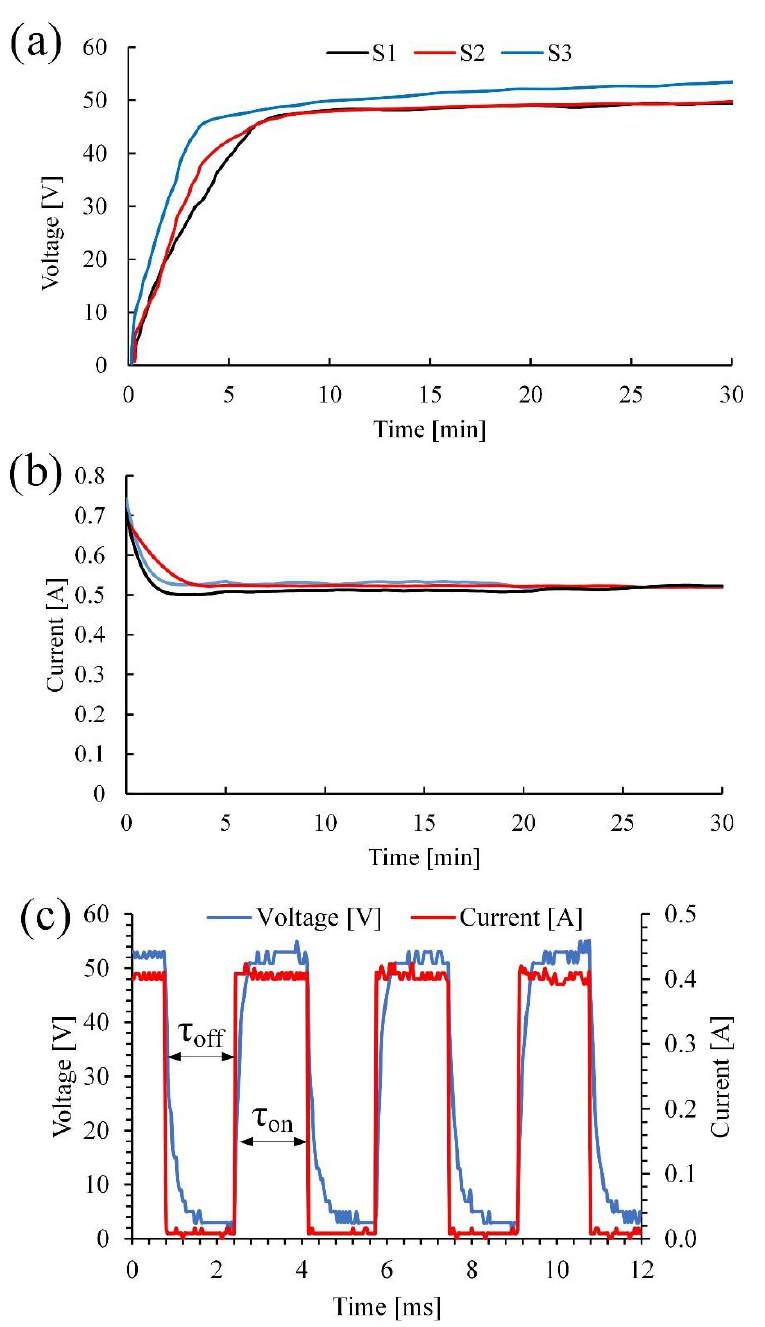
Figure 2. Voltage– and current–time and waveform curves for the PEO surface oxidation process of Figure 2. Voltage – and current – time and waveform curves for the PEO surface oxidation process of the Ti-6Al-7Nb alloy. ( a )Voltage–time plot; ( b ) Current–time plot; ( c ) Wave form the Ti-6Al-7Nb alloy. ( a )Voltage — time plot; ( b ) Current — time plot; ( c ) Wave form plot.